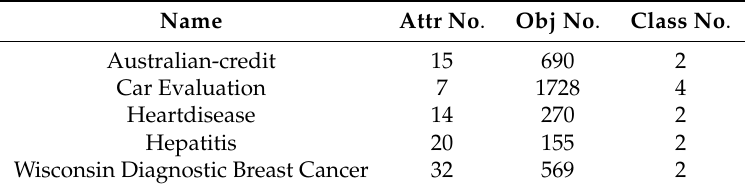
Table 10. Exemplary decision systems from UCI Machine Learning Repository. Australian credit, Car Evaluation, Heartdisease, and Hepatitis were used in the comparison of standard and concept-dependent granulation with a kNN Classifier. Comparing homogeneous variants with a kNN Classifier, we did not use the car system in the epsilon variant because it is symbolic. We used all four systems to present the effectiveness with the Classifier. To present the effectiveness with the SVM classifier, we used a Wisconsin Diagnostic Breast Cancer system [37].